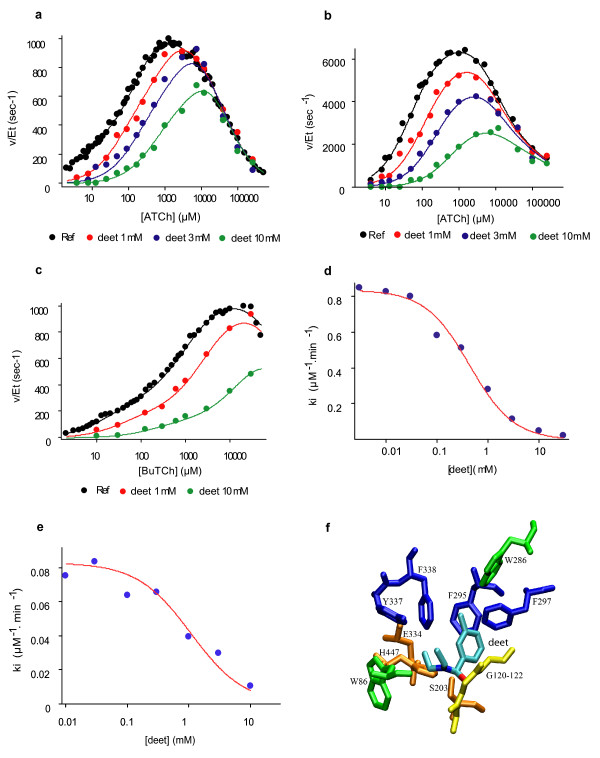
Effects of deet on cholinesterase enzymatic activities. a) and b) Inhibition of D. melanogaster (a) and Human (b) acetylcholinesterases (AChEs) by deet. Note the dose-dependant decrease of ATCh hydrolysis by AChE following deet application. [ATCh]: Acetylthiocholine concentration in micromole per liter; v/[Et] specific activity in s-1. c) Inhibition of human (Hu) butyrylcholinesterase by deet. As previously observed with ATCh, deet is also capable of strongly decreasing the BTCh hydrolysis by human BChE. [BTCh]: butyrylthiocholine concentration in micromole per liter; v/[Et] specific activity in s-1. d and e) Dose-dependant effect of deet on Drosophila (d) and Human (e) AChE carbamoylation rates by propoxur (carbamate). The curves clearly show the strong reduction of the second order rate constant (ki) for the carbamoylation of HuAChE by propoxur in presence of deet. At high concentration (10 mM), protection of AChE by deet is total. f) Accommodation and binding of deet inside the active site of Human AChE. The picture was created by VMD, a Visual Molecular Dynamics program. After QMMM relaxation of the complex between HuAChE and deet molecule, the latter was accommodated in a tetrahedral adduct conformation. Minimal adaptation of the side chains of adjacent residues in the active side of HuAChE suggests that the accommodation of deet in a position favourable for enzymatic hydrolysis is possible.